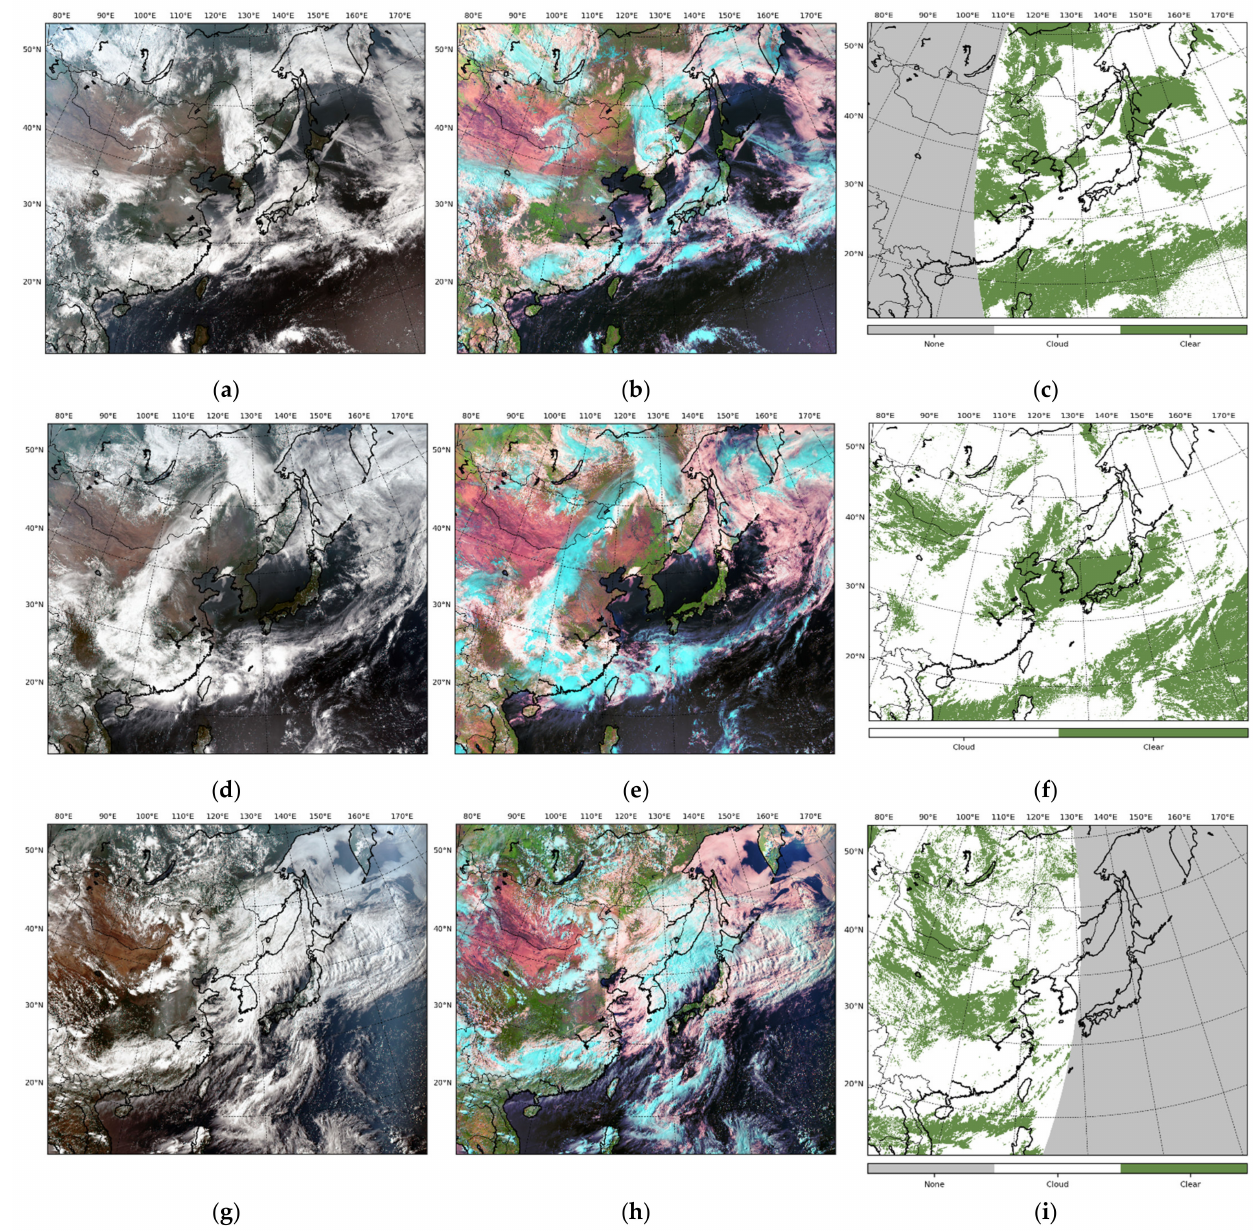
Figure 9. Qualitative comparison with GK-2A-based true color and natural color RGB in June 2020. Images are listed in the order of the true color, natural color, and proposed cloud mask, and each row is separated by date: ( a – c ) are at 00 UTC